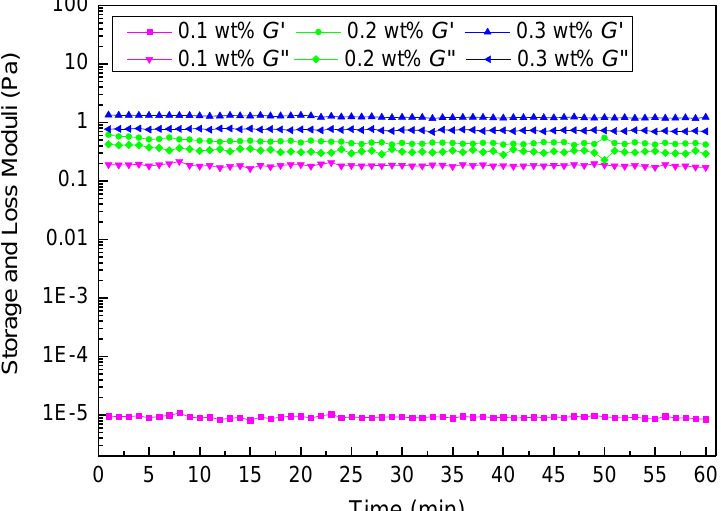
Figure 12. The G (cid:48) and G (cid:48)(cid:48) as a function of temperature for tested fluids. Figure 12. The G’ and G’’ as a function of temperature for tested fluids.